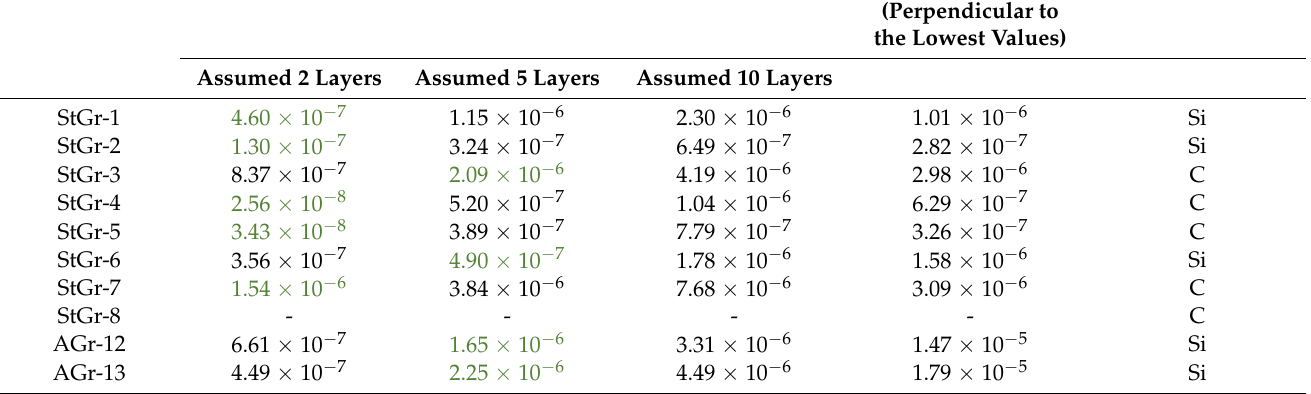
Table 2. Results of the resistivity measurements for all samples. The values indicate the average of several measurements at different spots at the same orientation, using Equation (3) for an assumed graphene sheet of 2 layers (6.7 Å), 5 layers (16.75 Å) and 10 layers (33.5 Å). The samples StGr-1, StGr-2, StGr-6, Agr-12, Agr-13 were grown on Si-face. The other samples were grown on the C-face of SiC. Sample StGr-8 did not show a complete cover of graphene on the substrate and thus did not produce any reliable results. Numbers colored in green were the ones that were found to represent the whole samples’ graphene thickness best, resulting from all collected